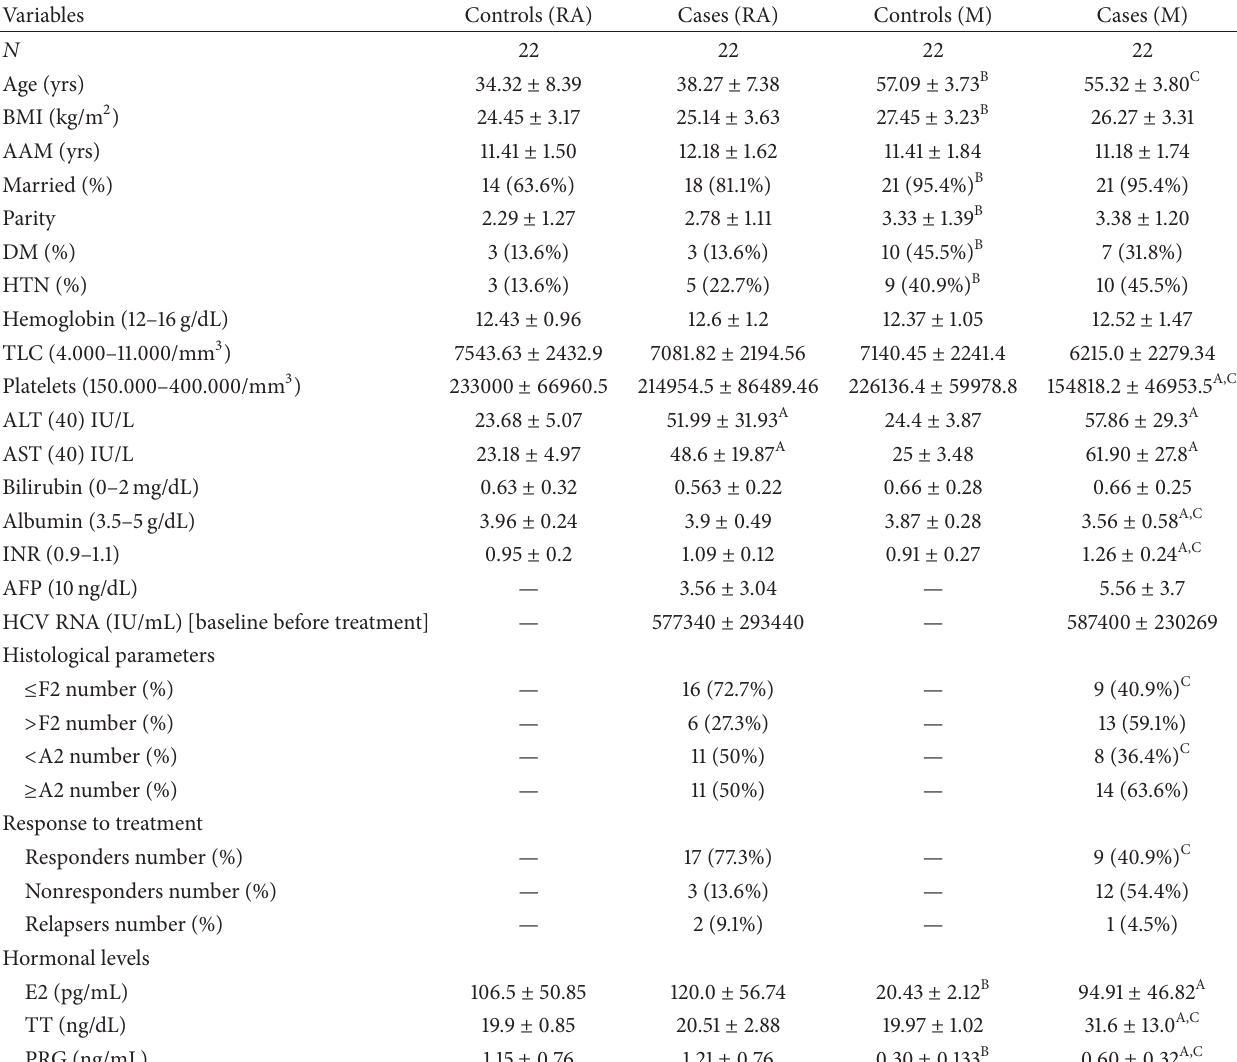
Table 1: Demographic, clinical, biochemical, and histopathological data of patients and healthy controls.